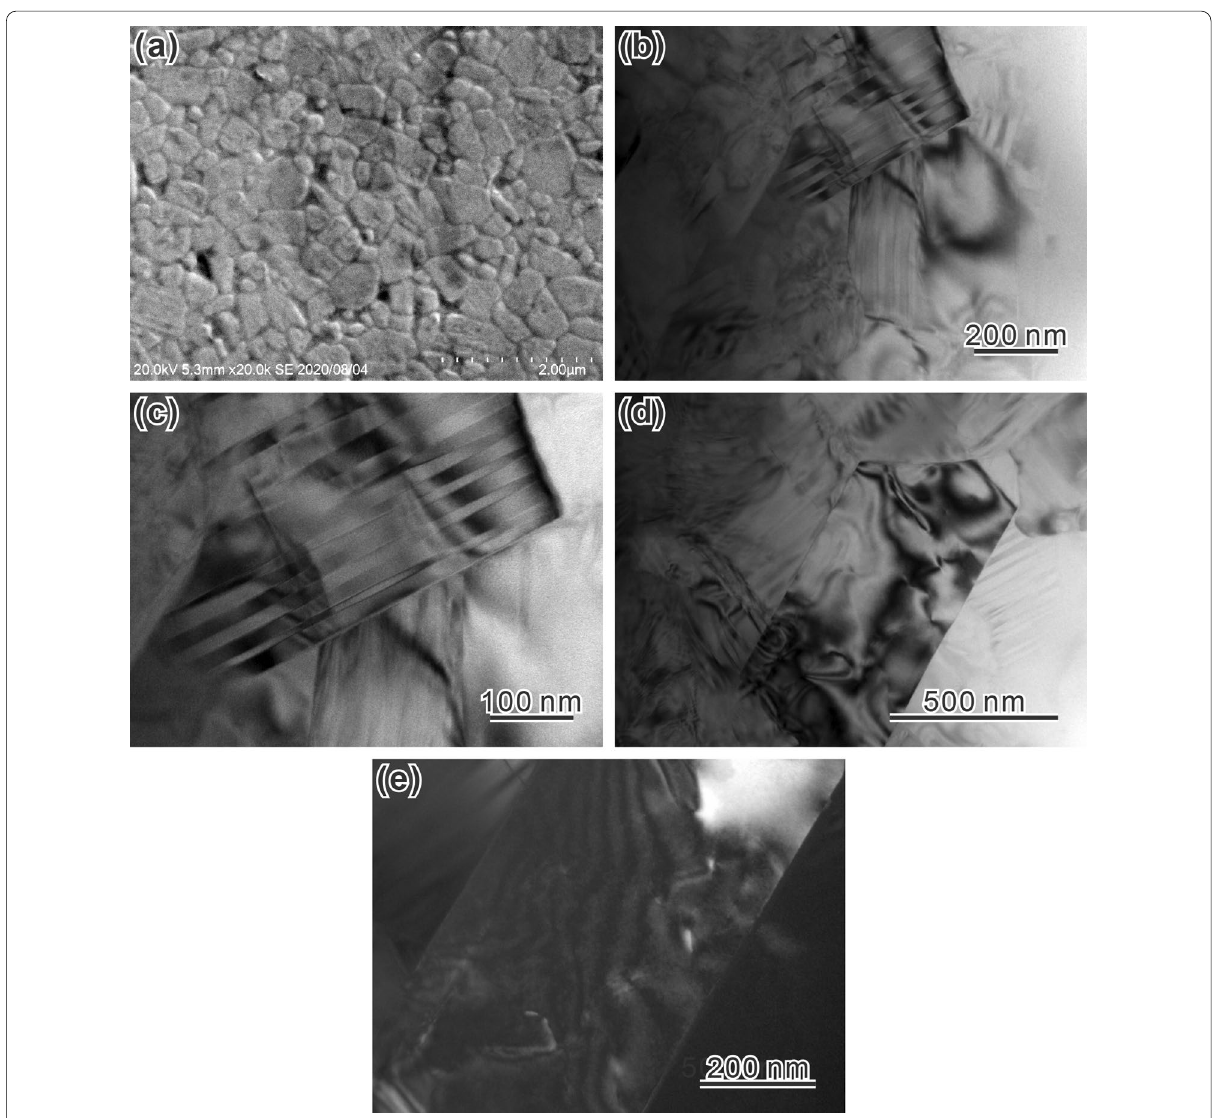
Fig. 11 Microstructural features of the dense albite aggregates. a SEI of a dense albite aggregate (Exp. #13) after 51 h annealing at 1050 °C. b – d TEM bright‑field (BF) images of a dense albite aggregate (Exp. #12). c An enlarged image of ( b ). e TEM dark‑field (DF) image of a dense albite aggregate (Exp. #12). The grain in ( e ) is the same as that in ( d ) under different diffraction